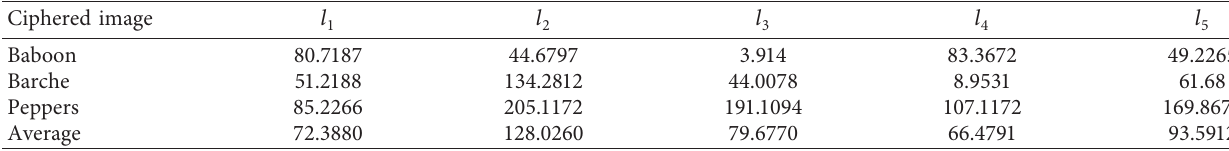
Table 7: Variances difference of histograms compared among all secret keys.